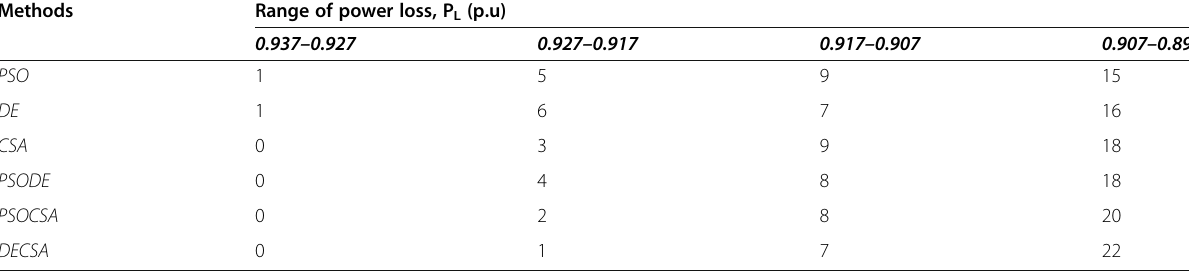
Table 14 Convergence recurrence of P L on the Indian 191-bus system from 30 trials Methods